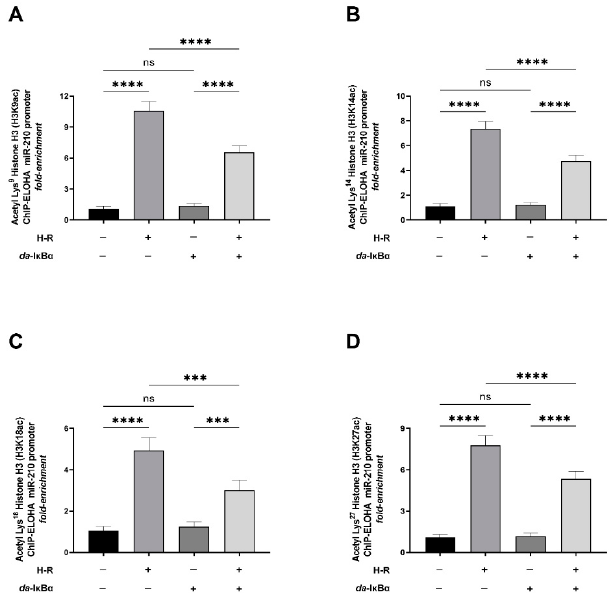
Figure 5. NF- κ B activation significantly mediates the hypoxia–reoxygenation (H-R) challenge-induced increase in acetylation of characteristic lysine residues in histone H3 that are signatory of an open permissive and transcriptionally active miR-210 promoter. ( A – D ) Tandem ChIP-ELOHA analysis showing the relative abundance of histone H3 acetylated at ( A ) Lys 9 —H3K9ac; ( B ) Lys 14 —H3K14ac; ( C ) Lys 18 —H3K18ac; and ( D ) Lys 27 —H3K27ac in the miR-210 proximal promoter in response to H-R challenge-subjected cells ectopically expressing the da -I κ B α mutant. Data from the ChIP-ELOHA